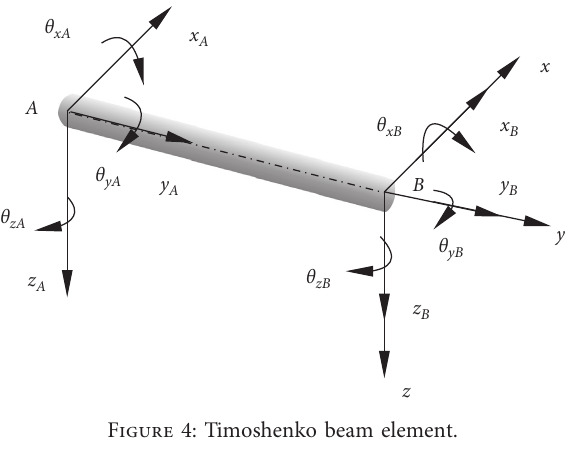
Figure 4: Timoshenko beam